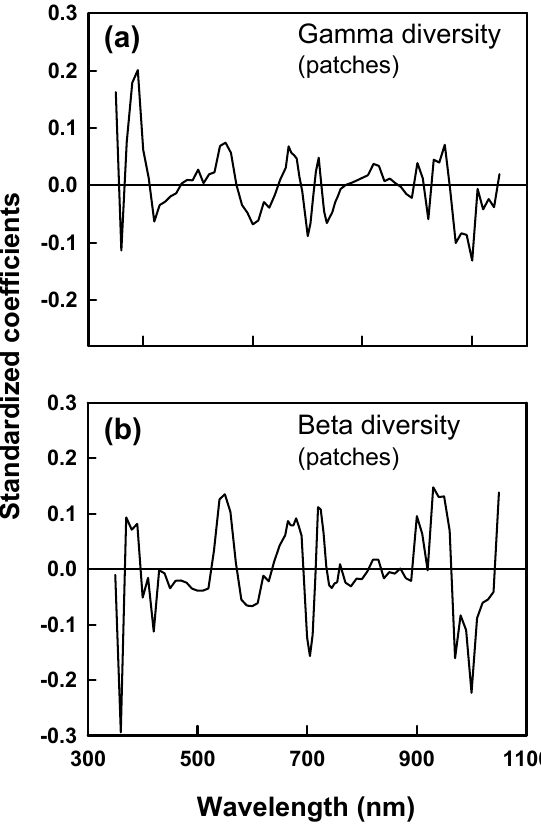
Figure 4. Standardized weightings of regression coefficients from PLSR relationships between two indices of species diversity and spatial heterogeneity in brightness normalized values of canopy reflectance: ( a ) γ diversity and ( b ) β diversity across eight plot (each 0.45 m 2 ) aggregates of grassland vegetation (patches; n = 48).